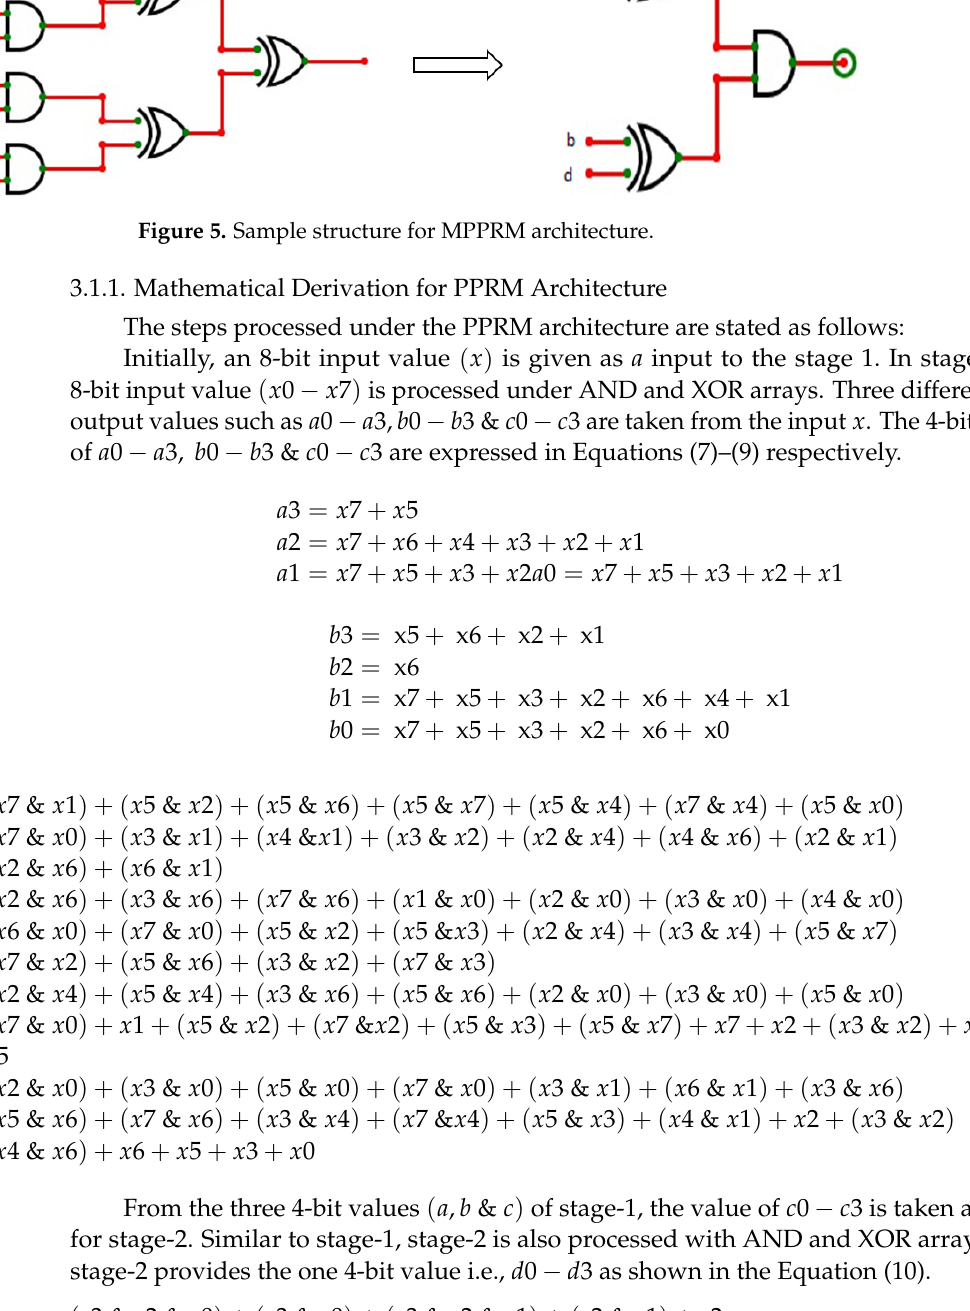
Figure 4. PRRM based SubByte transformation.